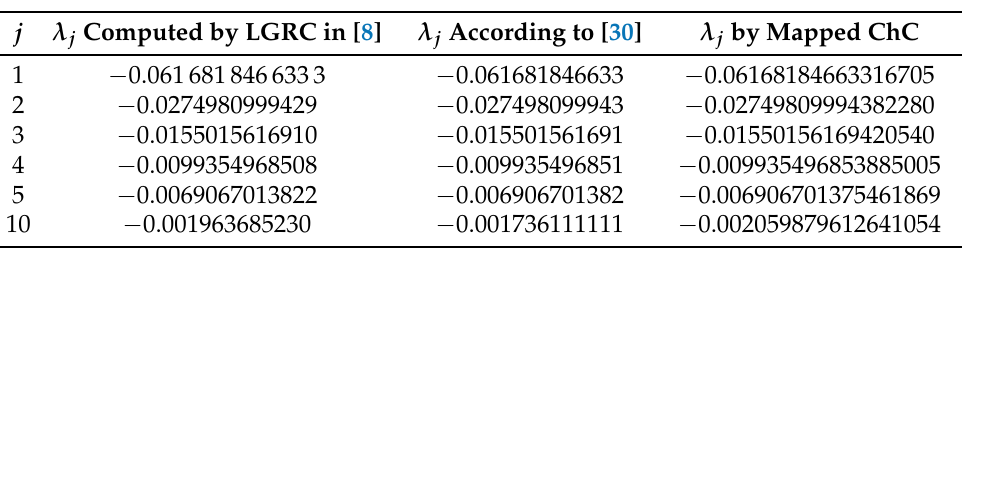
Table 3. The first five eigenvalues and the tenth one of the Schrödinger problem (1)–(6) when the potential has a Coulomb-type decay (9), computed by three different